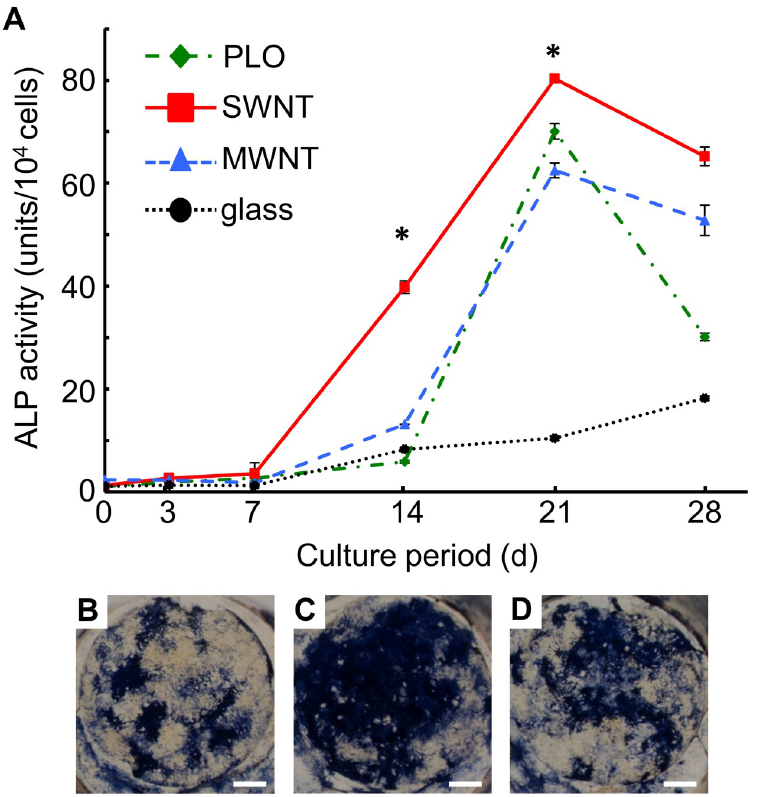
Fig 5. ALP activity of MSCs during osteogenic differentiation. Cells were cultured in osteogenic differentiation medium for 28 days. (A) ALP activities normalized by cell numbers were determined day 3, 7, 14, 21, and 28. The data are presented as mean ± S.D., n = 6 ( � : p < 0.05). In addition, ALP-stained cells are shown on (B) PLO-, (C) SWNT-, (D) MWNT-coated glass at day 28. Scale bar: 2